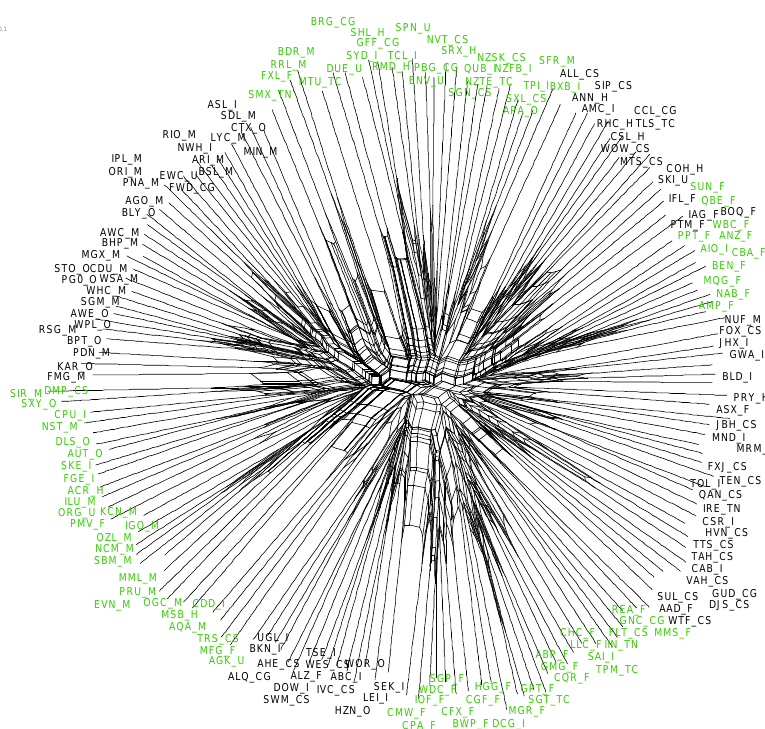
Figure 5. Period 4 neighbor-Nets splits graph with eight clusters. A one or two letter code has been appended to each stock’s three letter ticker symbol to indicate what industry group it belongs to using the codes assigned in Table 1.